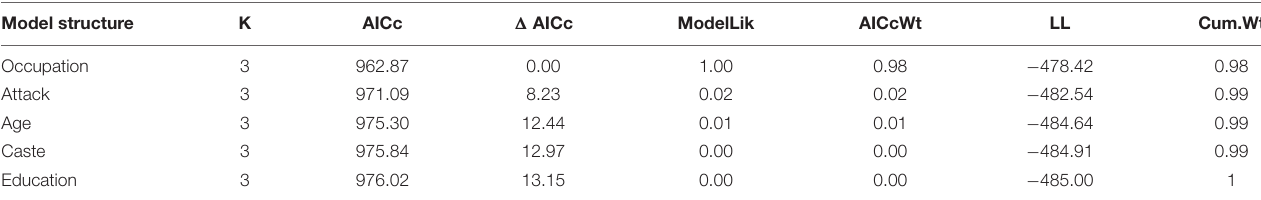
FIGURE 3 | Comparison of attitudes of respondents toward the wolves, for the question “what should be done to reduce the loss caused by wolves”. TABLE 5 | Model comparison for socio-demographic factors (Occupation, Attack, Age, Caste, Education) affecting attitudes of respondents toward the wolf in Kailadevi Wildlife Sanctuary, Rajasthan,